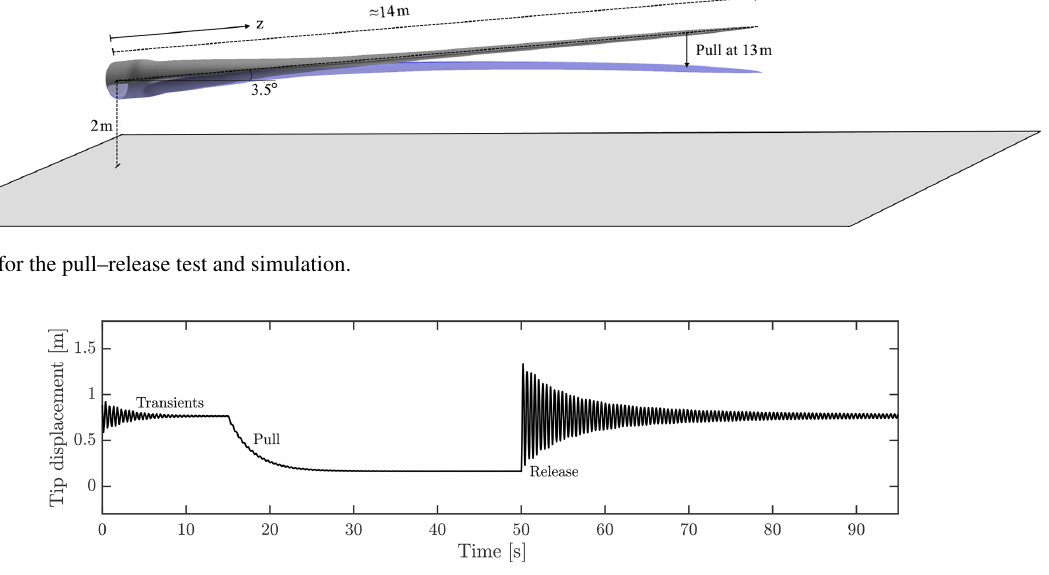
Figure 2. The full simulation time series of tip